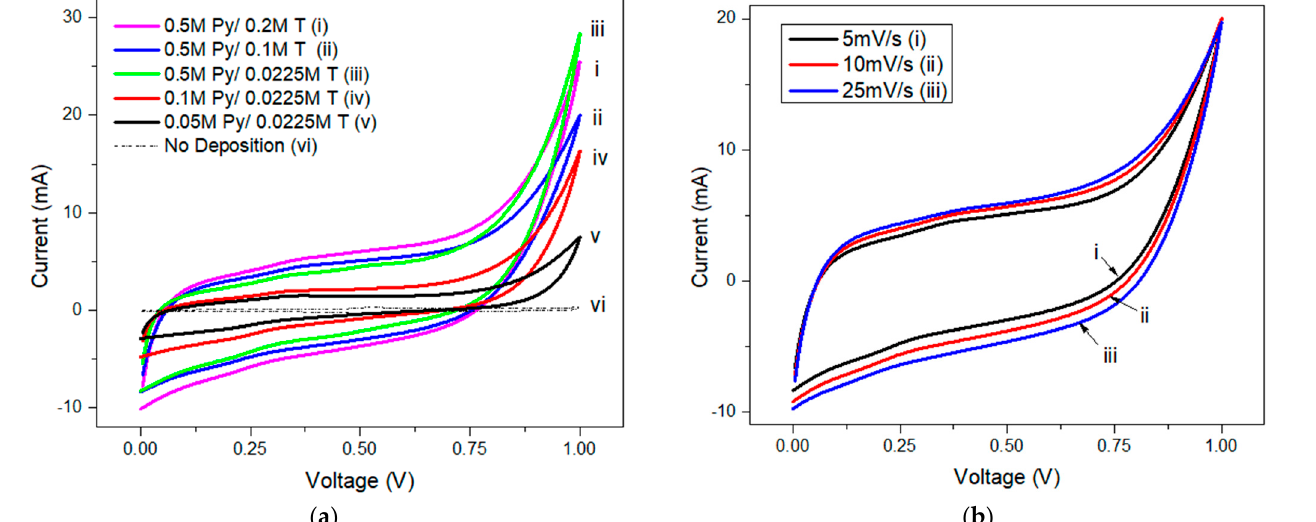
Figure 4. ( a ) 5 mV/s cyclic voltammograms of 50 wt%SWCNT/PI nanocomposite electrode with doped PPy at varying deposition conditions. ( b ) CV profile of nanocomposite electrode with electrodeposited PPy from a 0.5M Py/0.1M pTSA solution run at 5, 10, and 25 mV/s scan rates using a Ag/AgCl reference electrode.